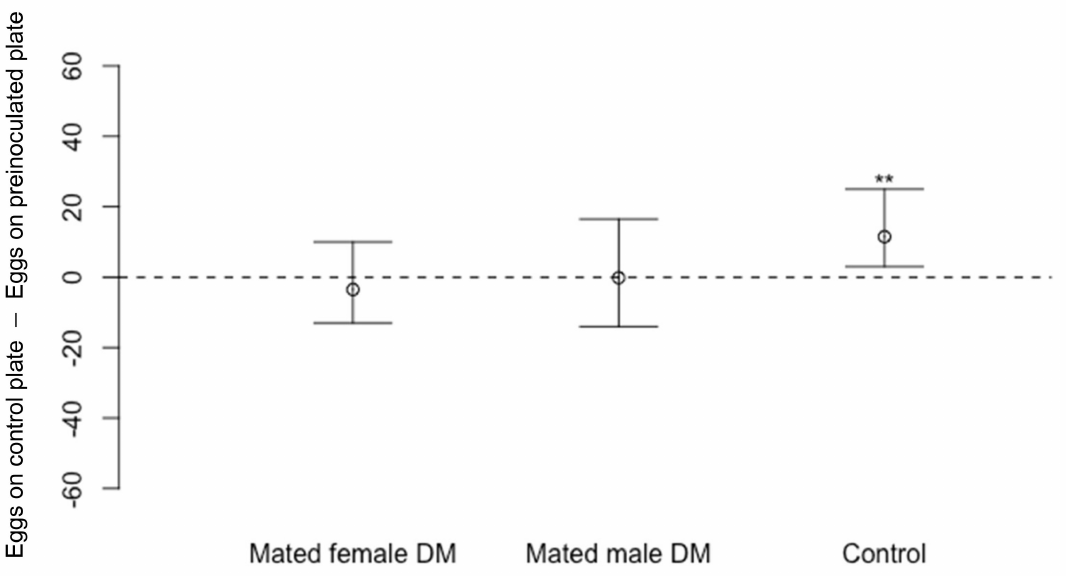
Figure 4. Differences in numbers of eggs laid by Drosophila suzukii (Median ± 95% confidence intervals) on cornmeal media dishes previously exposed to mated D. melanogaster (DM) females ( n = 16, p = 0.50) or males ( n = 16, p = 1.00) compared to a blank dish not previously exposed to D. melanogaster . In the control experiment, D. suzukii laid fewer eggs on cornmeal media dishes previously exposed to male and female D. melanogaster compared to blank dishes ( n = 16, p < 0.01 ** ).